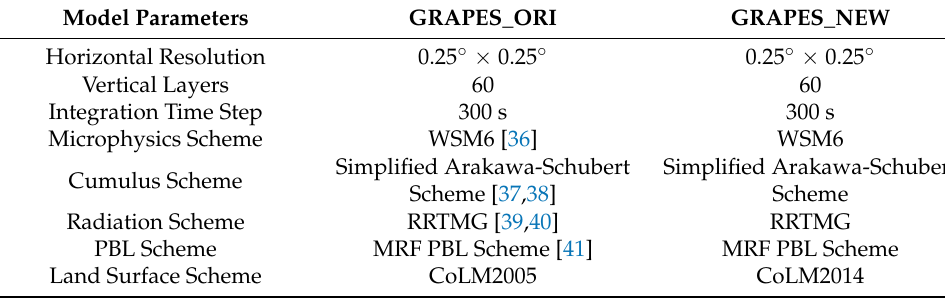
Table 1. Model parameters used in GRAPES forecast